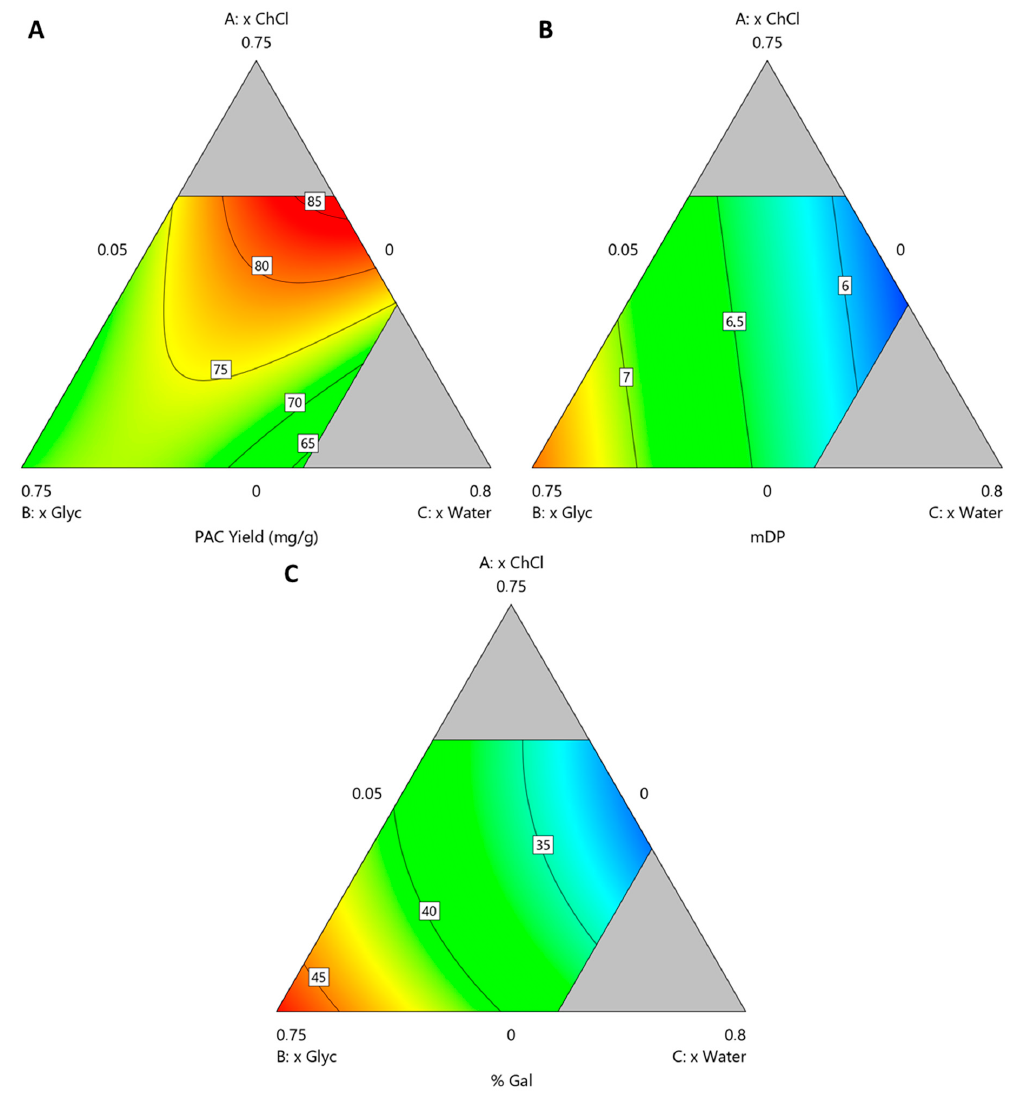
Figure 4. Contour plots obtained for solvent compostiion optimization at x EtOH = 0.2 for ( A ) Y PAC , ( B ) mDP and ( C ) %Gal.